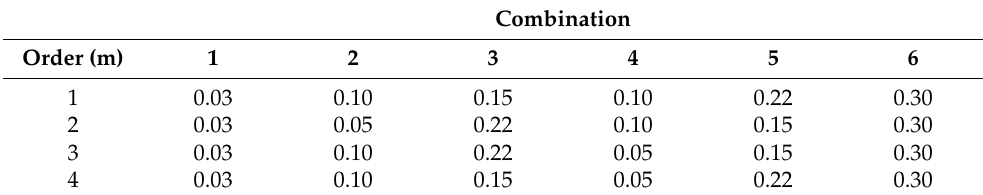
Table 3. Working model of DLT probabilities under each